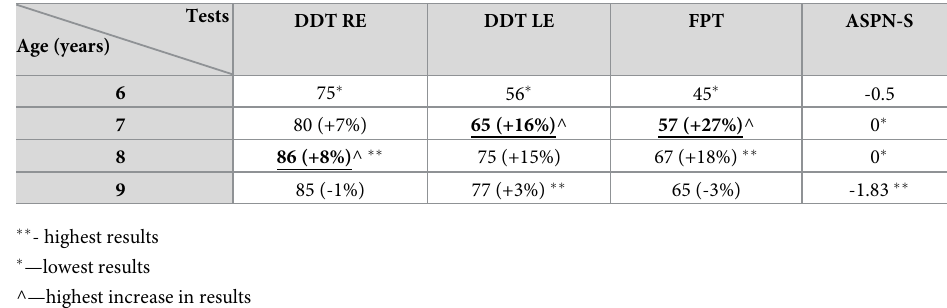
Table 16. Comparison of median APD result in age groups in